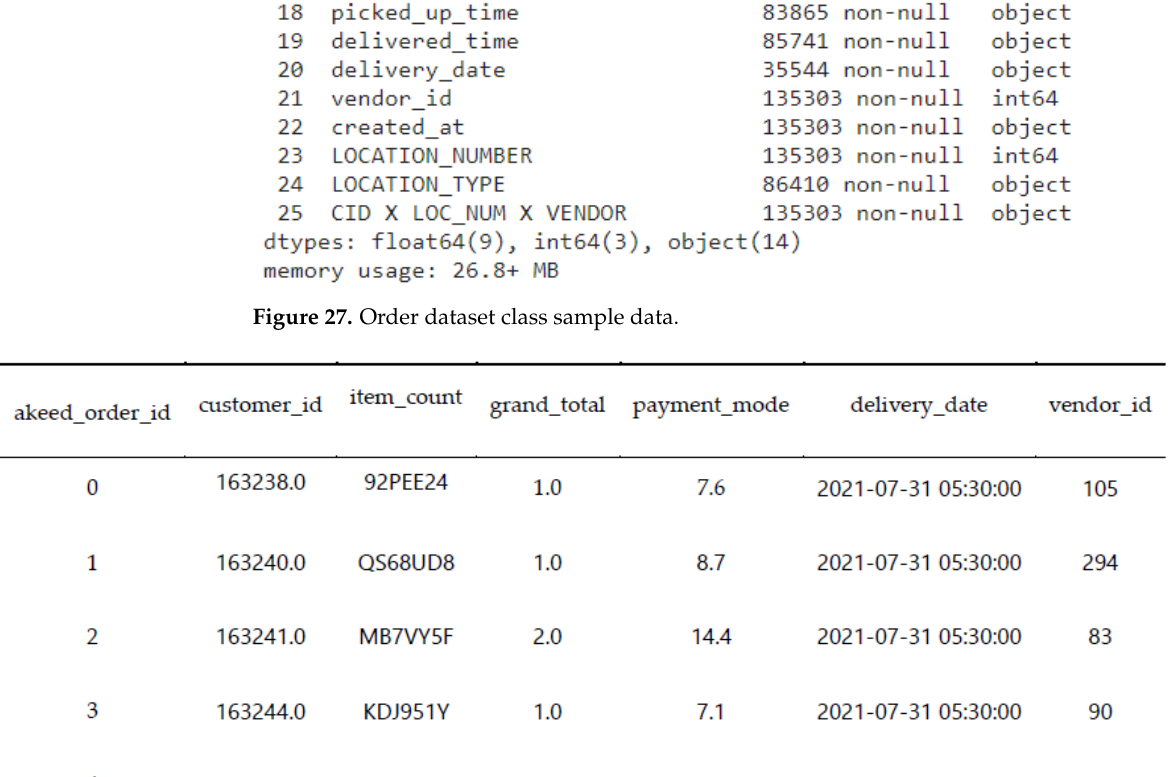
Figure 28. Sample order dataset.